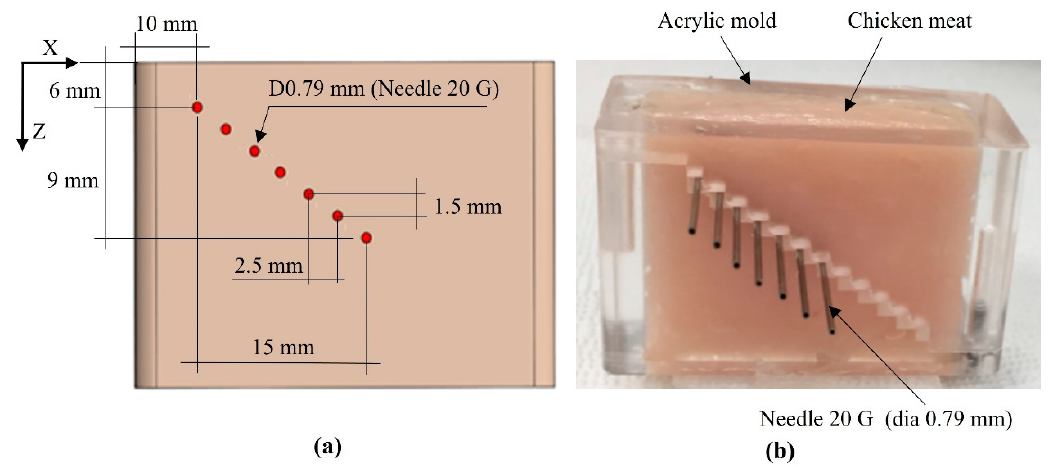
Figure 7. (a) The structure and (b) a photograph of the chicken-needle (CN) phantom.